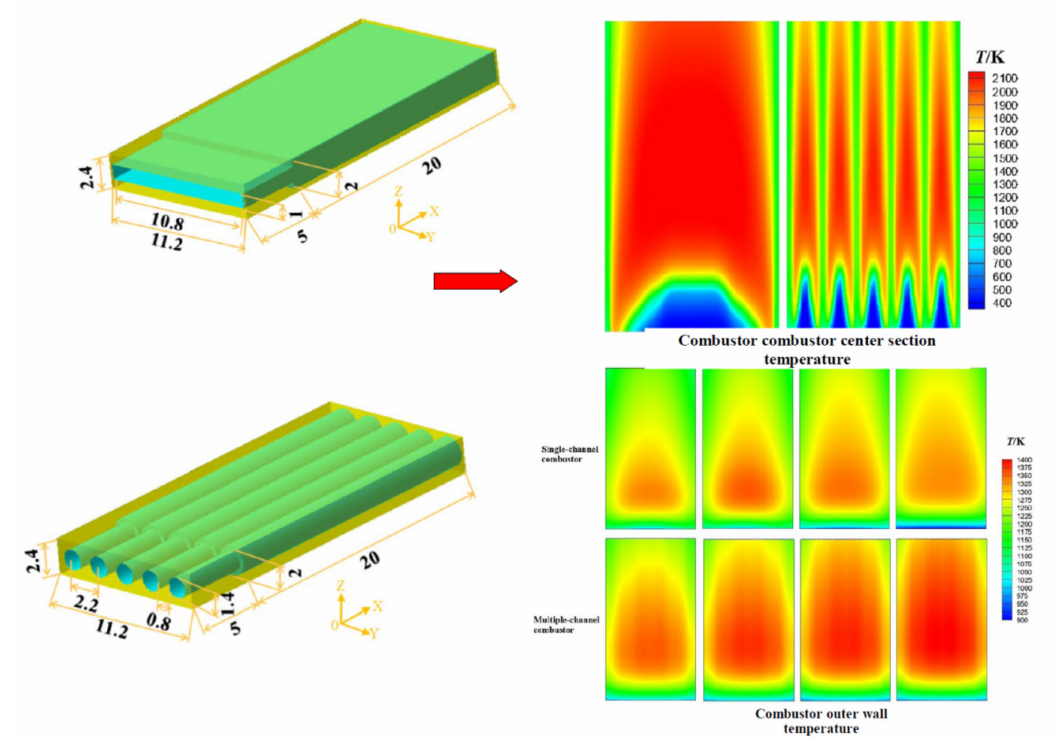
Figure 26. Schematic of the micro combustor and the temperature fields.